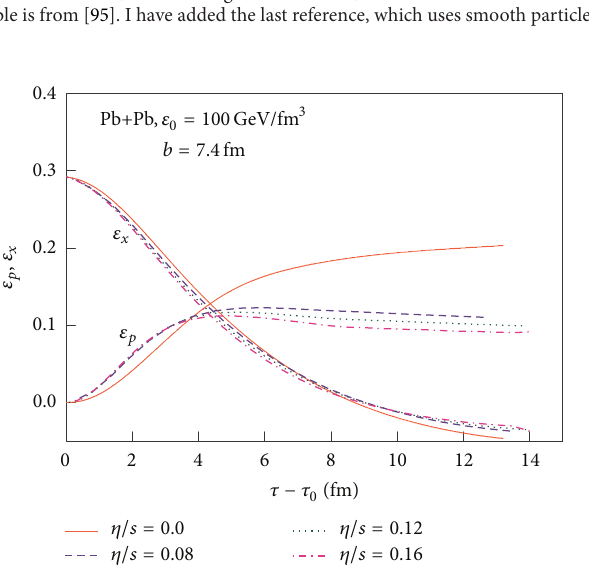
Figure6:Idealandviscoushydrodynamicsimulationsforevolution of spatial eccentricity (𝜖 𝑥 ) and momentum anisotropy (𝜖 𝑝 ) in 𝑏 = 7.4 fm Pb+Pb